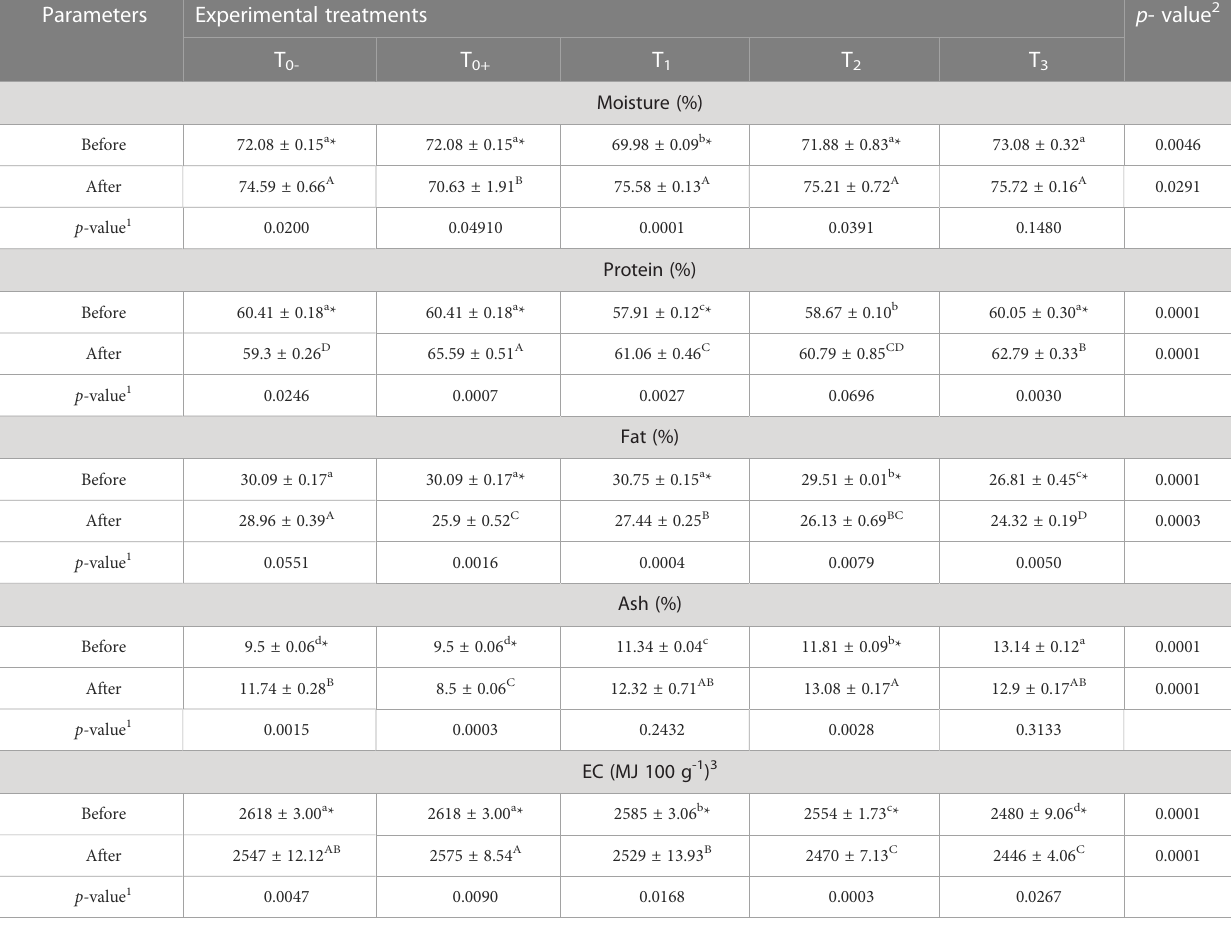
TABLE 2 Chemical composition of hybrid red tilapia body fed different ratios of corn oil: Aquafat-O ® and exposed to chronic cold stress. Parameters Experimental